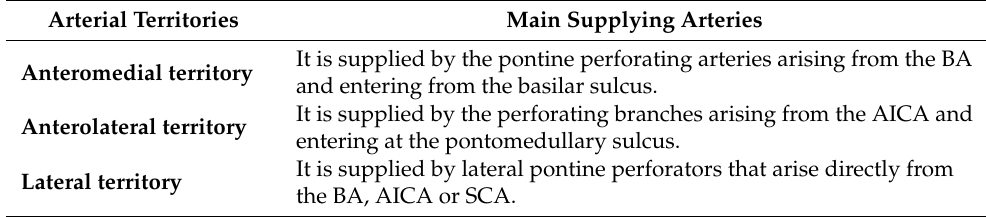
Table 2. Arterial territories of the pons and main arterial supply